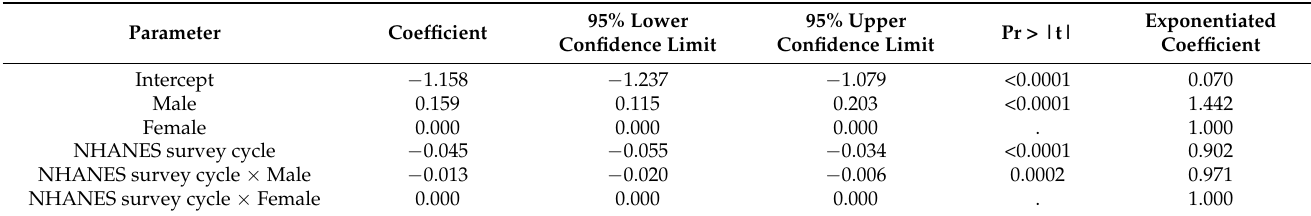
Table A7. Sample-weighted linear regression model results of serum cotinine for U.S. nonsmokers aged ≥ 3 years by sex from 2003 to